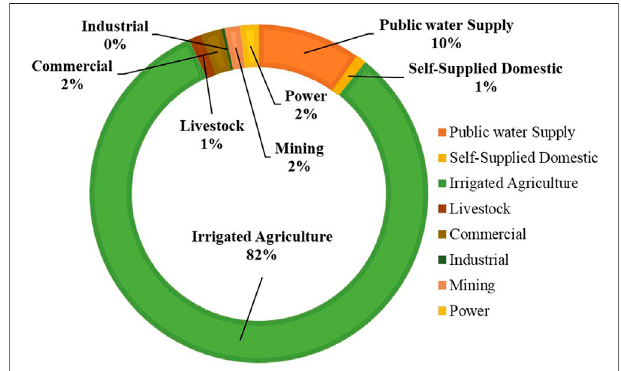
FIGURE 6 | New Mexico water use by categories in